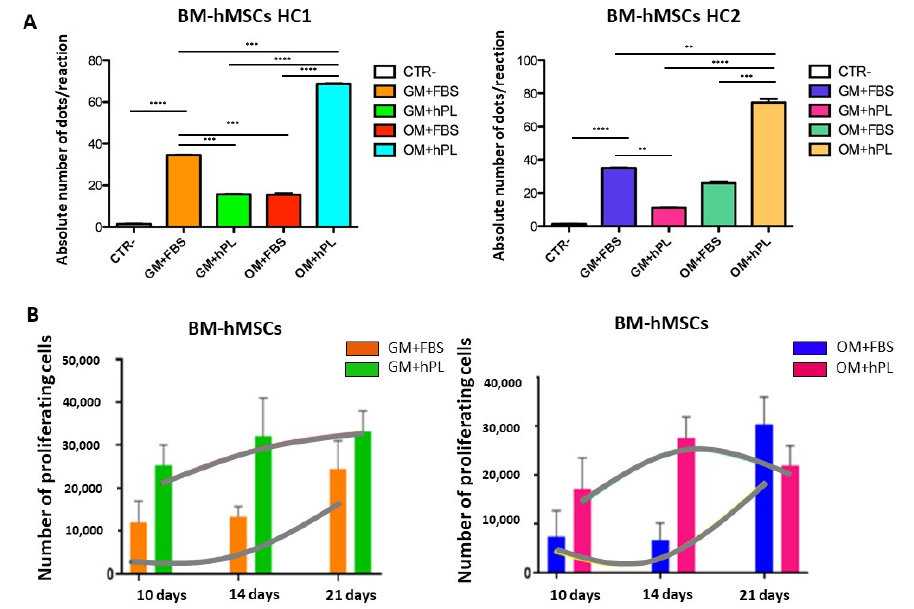
Figure 3. Osteogenic di ff erentiation of BM-hMSCs evaluated by OPN transcript absolute quantification. ( A ) The figure reports the absolute quantification of the OPN transcript level obtained by dPCR analysis of BM-hMSCs at 21 days. All conditions are reported: GM + FBS, GM + hPL, OM + FBS, OM + hPL, for HC1. GM + FBS, GM + hPL, OM + FBS, OM + hPL, for HC2. CTR- obtained by 2D culture of BM-hMSCs cultured with GM served as a negative control. Data are expressed as the absolute number of positive dots / reaction. Statistical significances calculated by t -tests with Welch’s correction (* p ≤ 0.05, ** p ≤ 0.01, *** p ≤ 0.001, **** p ≤ 0.0001). ( B ) BM-hMSCs proliferation trends. Proliferating BM-hMSCs cultured in HC1 in the presence of GM + FBS and in the presence of GM + hPL, and cultured in HC2 in the presence of GM + FBS and in the presence of GM + hPL are reported at di ff erent time points (10, 14, and 21 days). AT-hMSCs cultured with OM + hPL presented the highest quantity of the OPN transcript in both sca ff old HC1 and sca ff old HC2 (Sca ff old HC1 OM + hPL vs. GM + FBS, p = 0.0237; Sca ff old HC1 OM + hPL vs. GM + hPL, p = 0.0314; Sca ff old HC1 OM + hPL vs. OM + FBS, p = 0.0215; Sca ff old HC2 OM + hPL vs. GM + FBS, p = 0.0005; Sca ff old HC2 OM + hPL vs. GM + hPL, p = 0.0011; Sca ff old HC2 OM + hPL vs. OM + FBS, p = 0.0002), similar to what was observed in BM-MSCs. Moreover, both sca ff old HC1 and sca ff old HC2 induced the transcription of OPN in AT-MSCs when cultured with GM + FBS, without other di ff erentiation stimuli (HC1 GM + FBS vs. CTR-, p = 0.0007; HC2 GM + FBS vs. CTR-, p = 0.0101). (Figure